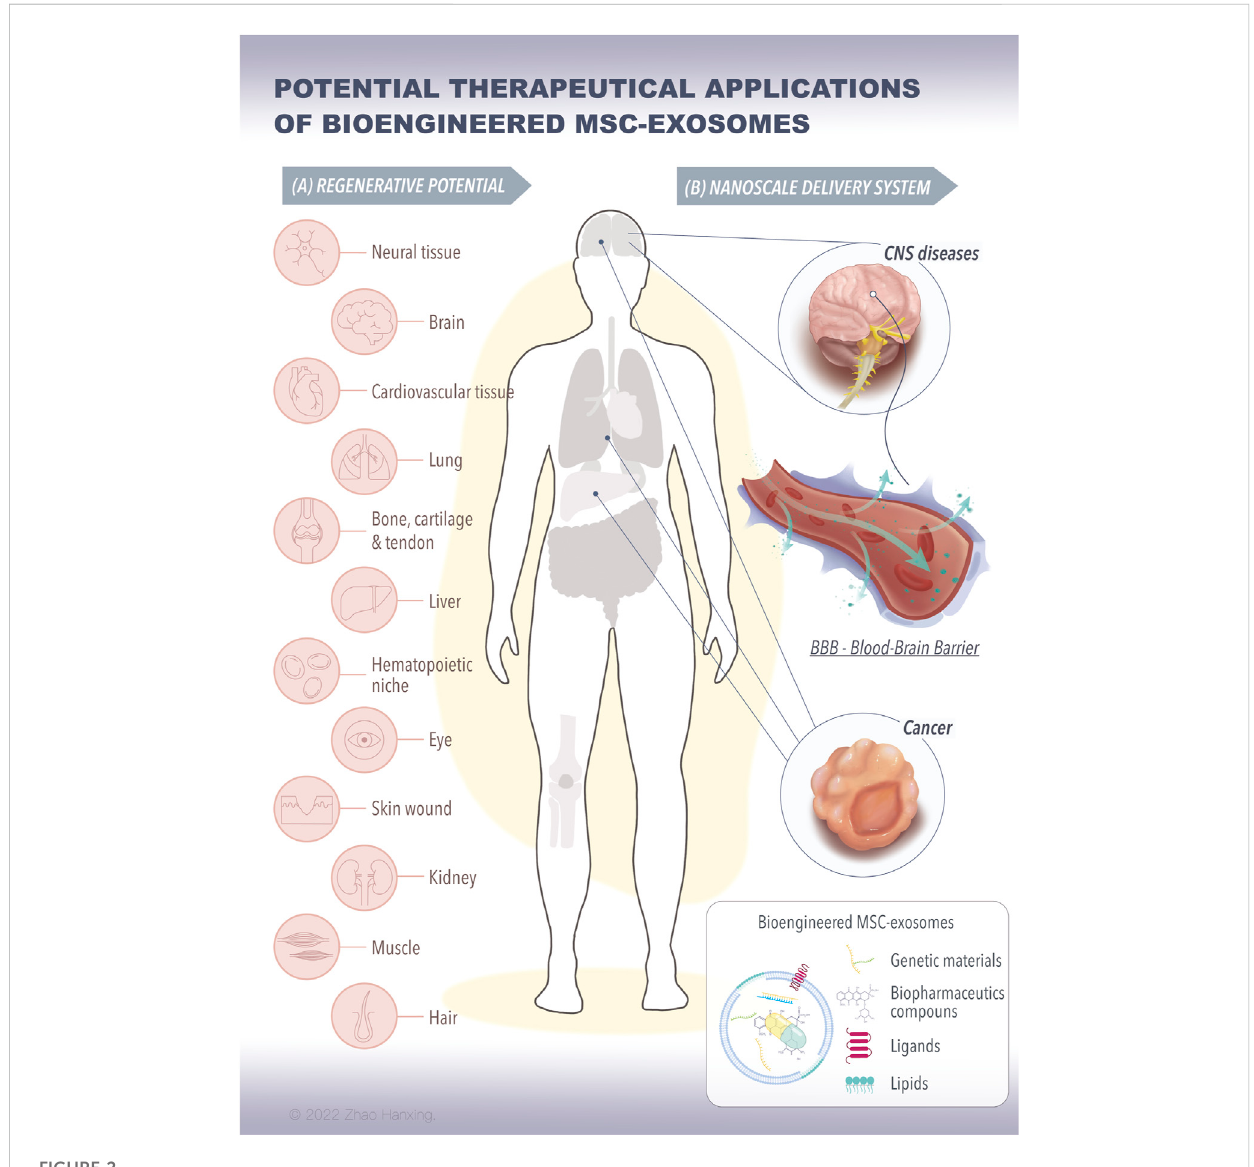
FIGURE 2 The potential therapeutical applications of bioengineered MSC-exosomes for tissue regeneration and nanoscale delivery system. (A) The bioengineered MSC-exosomes loading with speci fi c signaling molecules, such as proteins, RNAs, and nanoparticles can achieve repair and regenerative effects on various tissues. (B) The bioengineered MSC-exosomes can cross the BBB in the brain or to the tumor for the treatment of CNS diseases and cancer. (MSC, mesenchymal stem cells, BBB, blood-brain barrier, CNS, central nervous system).